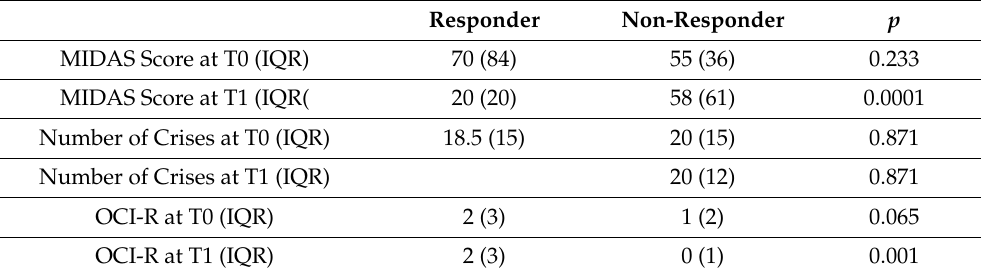
Table 2. Differences between responder and non-responder